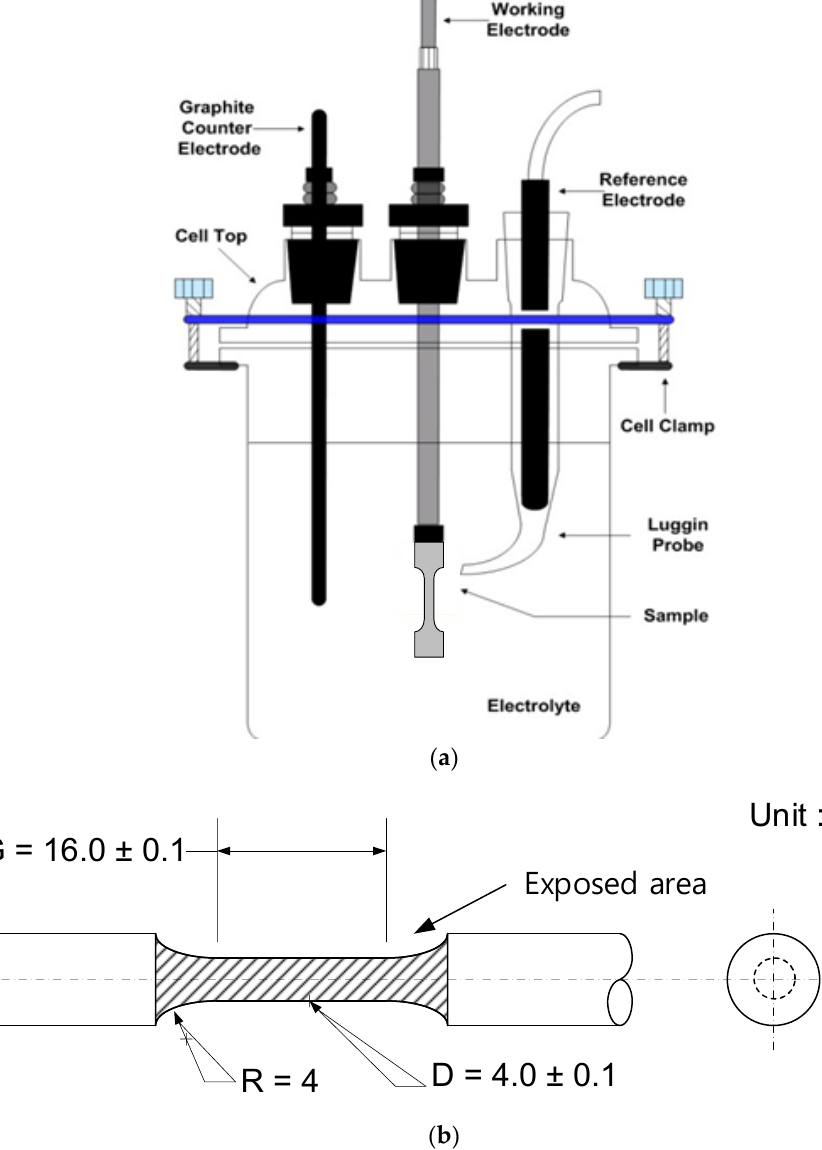
Figure 2. Schematic illustrations of ( a ) the three-electrode cell and ( b ) the exposed area of the specimen.